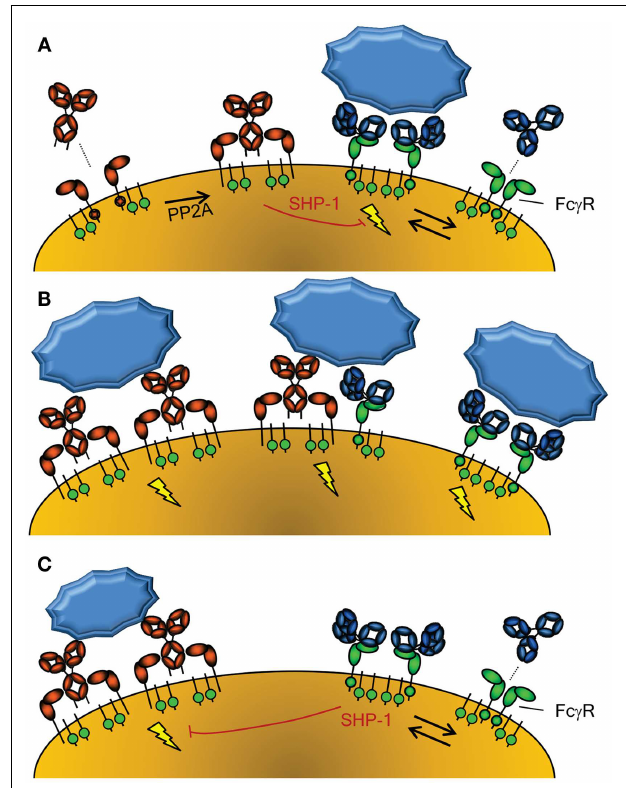
FIGURE 2 |Activation of cellular responses through Fc-Receptors . (A) The activity of Fc α RI (left) is controlled through inside-out signaling through PP2A, that dephosphorylates the intracellular tail of Fc α RI, enabling binding of IgA (58). Conversely, Fc γ R (right) seem to be continuously enabled, although crystallographic data suggest a dimeric form may exist that cannot interact with IgG without disrupting the inert Fc γ RIIa dimer (115).The Fc γ RIIa engaged by IgG may however form a higher order dimer, or multimer, with either another Fc γ R-IgG unit or unligated Fc γ R, forming an active signaling complex after engagement with IgG-opsonized target. However, without crosslinking of Fc α RI through IgA and it’s cognate antigen, the Fc α RI has been reported to lead to down regulation of Fc γ RI signaling through phosphorylated SYK (58). (B) Importantly, co-engagement of Fc γ R and Fc α R results in a strong activation of phagocyte responses, with Fc α RI leading to a more prominent respiratory burst activation, while Fc γ R result more a prominent phagocytosis response (54). (C) Fc γ R can also mediate inhibitory signal, because IgG-ligated, either by monomers at high concentrations, dimers, or F(ab’) 2 -anti Fc γ R, can also cause inhibition of other ITAM-, but also non-ITAM, depended cellular activation, also through phosphorylated SYK